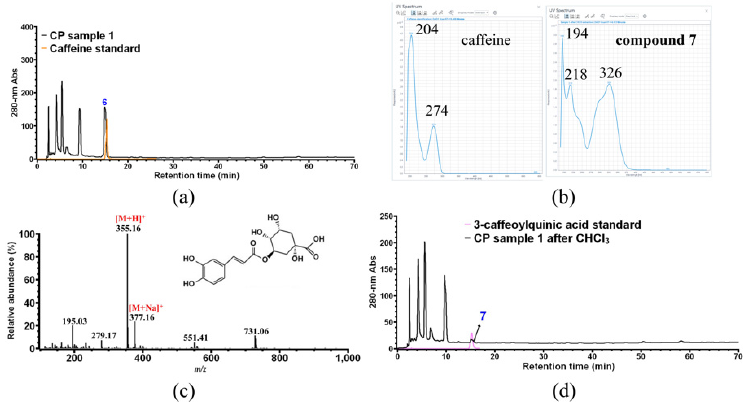
Figure 7. Identification of CP compounds 6 and 7 . ( a ) HPLC overlay chromatogram of CP sample 1 and commercial caffeine; ( b ) UV-vis spectrum analysis of caffeine standard and compound 7 ; ( c ) MS analysis of compound 7 ; ( d ) HPLC overlay chromatogram of 3-caffeoylquinic acid standard and CP sample 1 after CHCl 3 treatment.